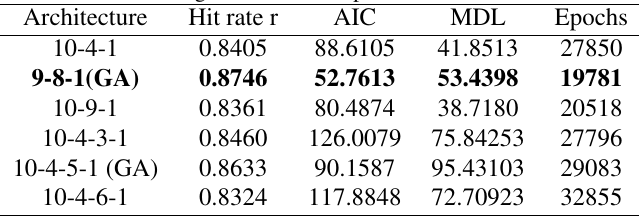
Table 11. Stage 3 results. Comparison of architectures